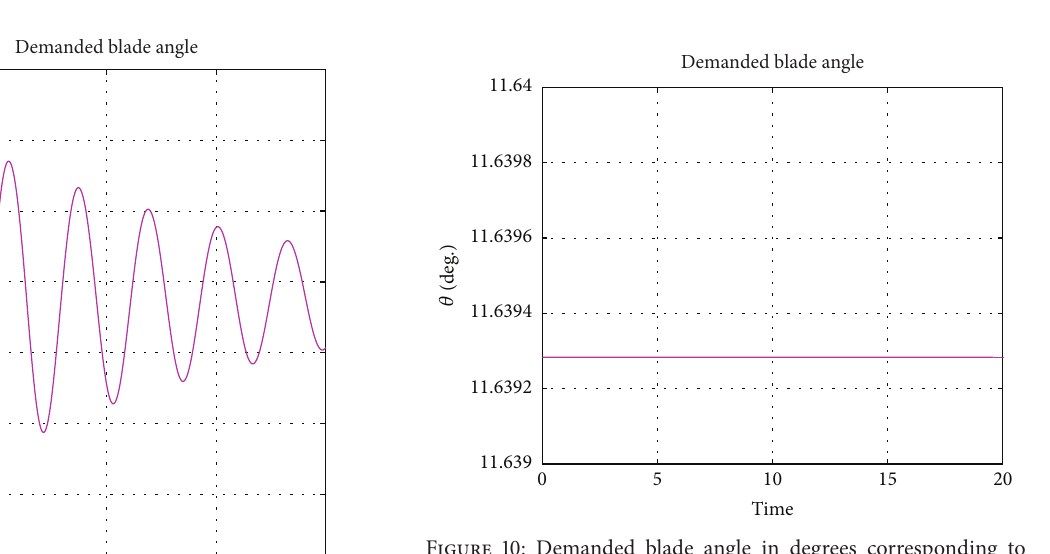
Figure 9: Response curves for the power output with the prescribed limit set at 0Kw.